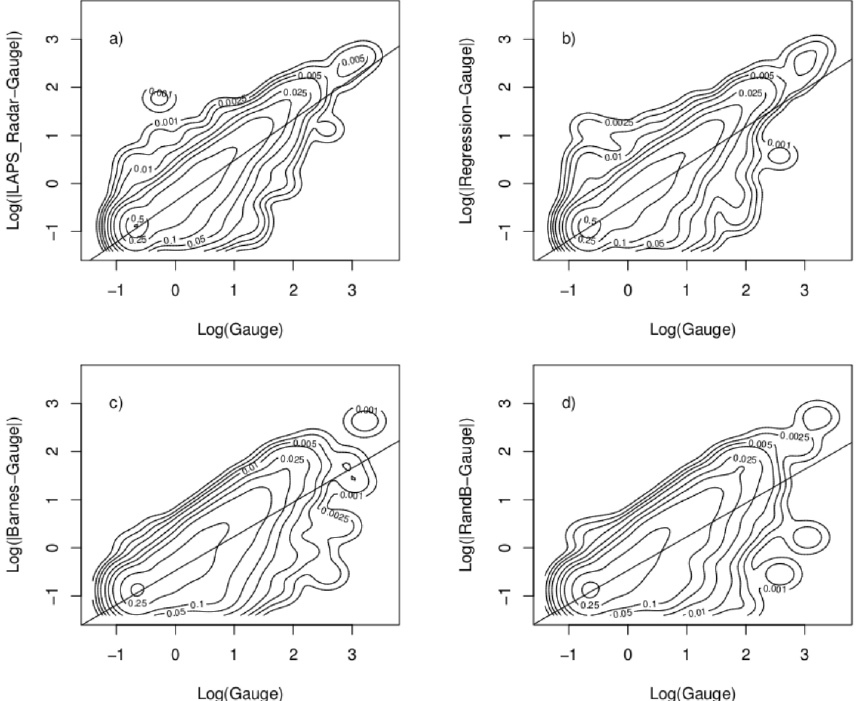
Fig. 5. Absolute value of the difference between observed and analyzed precipitation accumulation ( y axis) plotted against rain-gauge values ( x axis), for the seven independent stations: (a) |LAPS radar-Gauge|; (b) |Regression-Gauge|; (c) |Barnes-Gauge|, and (d) |RandB-Gauge|. The continuous line is a linear fit to the data set.